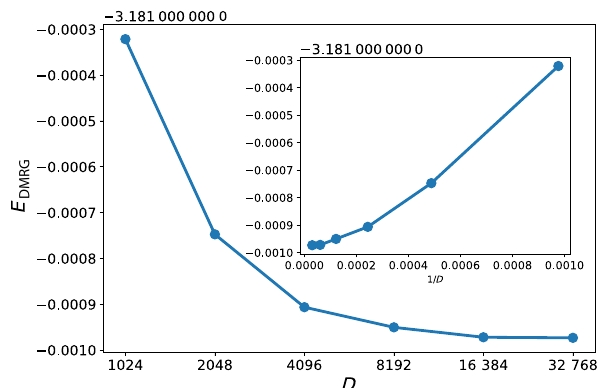
FIG. 3. Convergence of the DMRG ground-state energy per site as a function of bond dimension D for the critical trans- verse field Ising model on a 20 × 20 lattice, leading to an energy density of − 3.181 97 ( 2 ) . For comparison, Lubasch et al. [124] obtained the values − 3.172 10 ( 1 ) and − 3.182 43 ( 1 ) for the energy density using a PEPS simulation on 11 × 11 and 21 × 21 lattices, respectively.